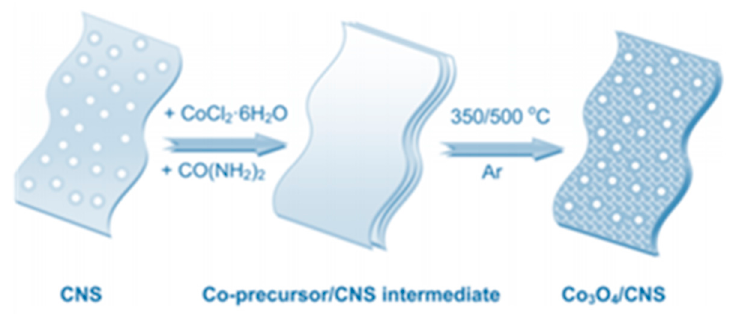
Figure 16. Powder XRD patterns of CNS, Co 3 O 4 / CNS hybrids, and bare Co 3 O 4.